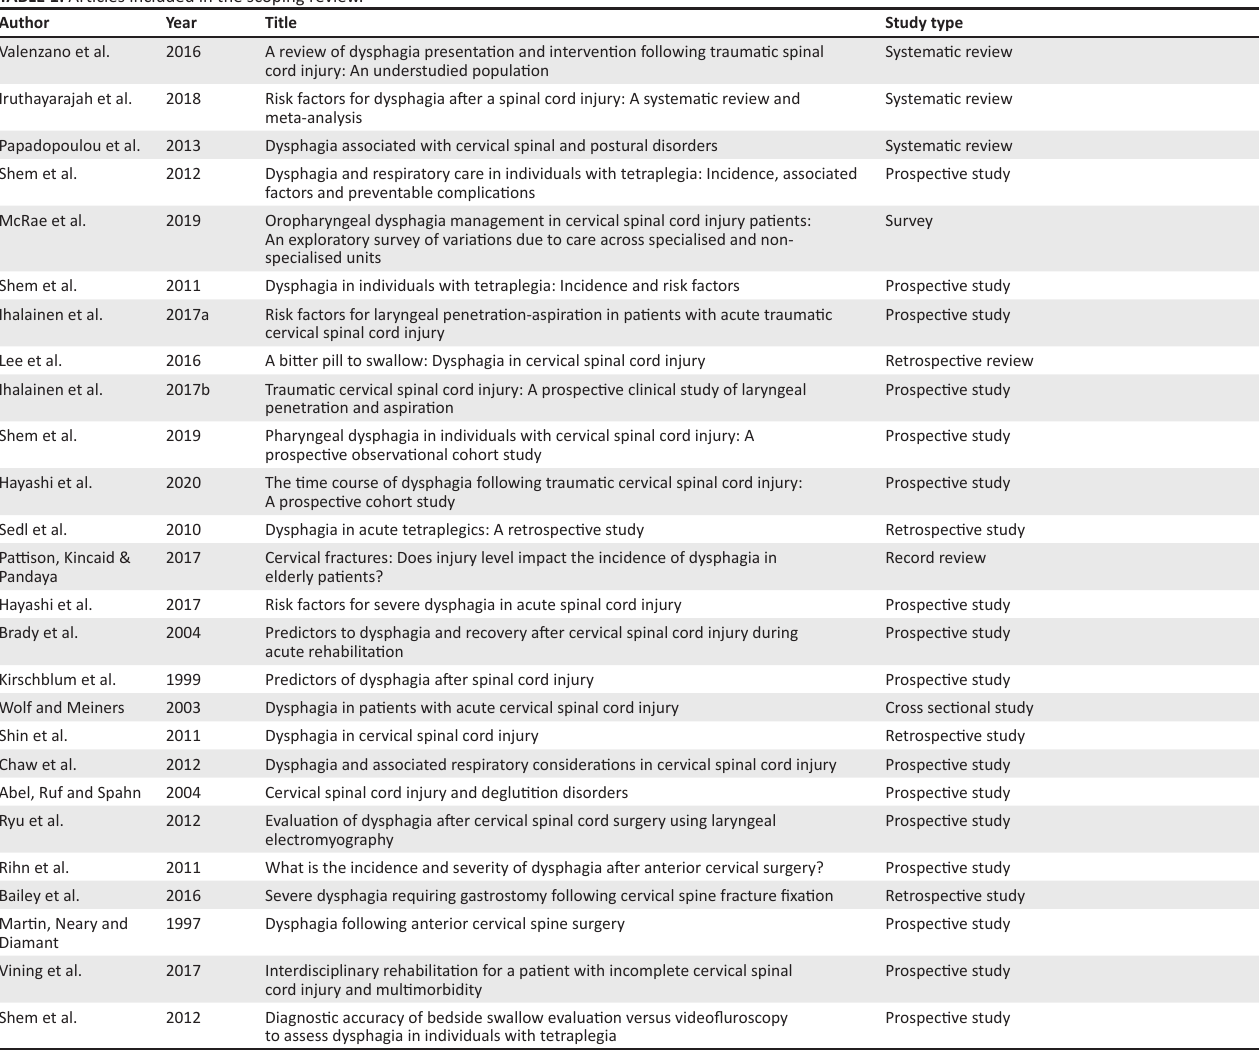
TABLE 1 : Articles included in the scoping